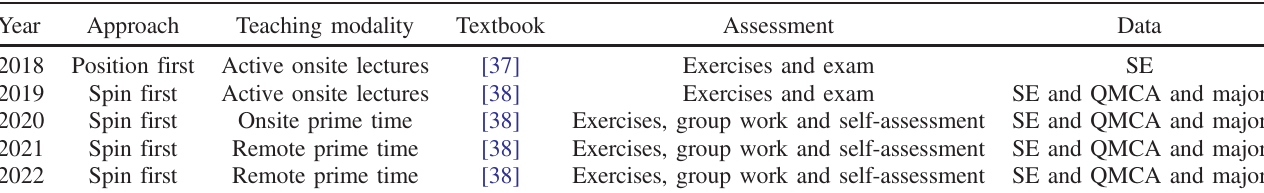
TABLE I. Summary of the teaching reforms by